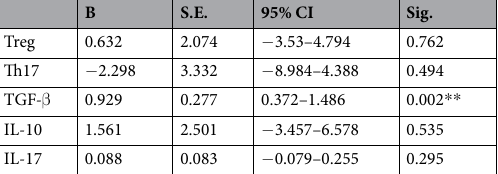
Table 3. The correlation of serum VEGF levels with various parameters by linear regression analysis. B, coefficients; S.E. : SEM; ** P <